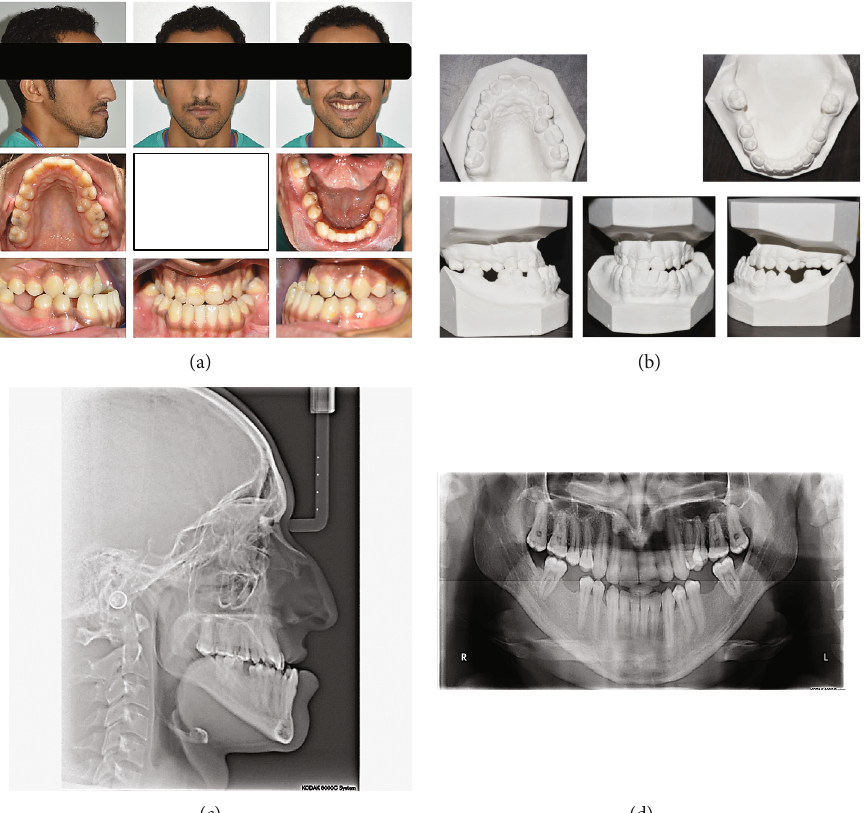
Figure 1: Pretreatment extraoral and intraoral photographs, study models cephalometric radiograph, and panoramic radiographs of the patient: (a) extraoral and intraoral photographs; (b) study models; (c) cephalometric radiograph; (d) panoramic